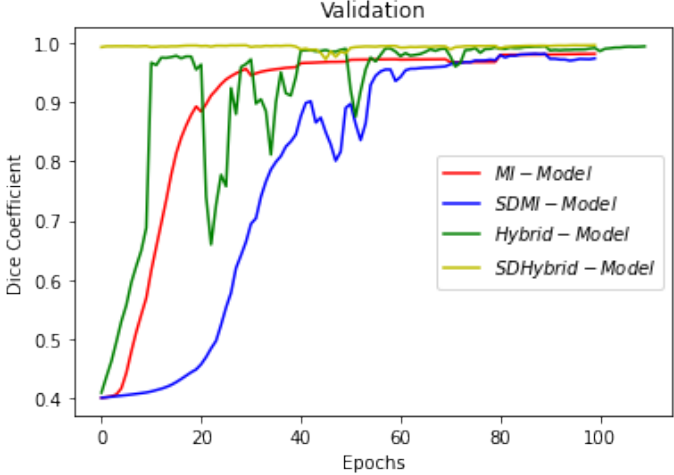
Figure 23. Comparison of Validation Dice